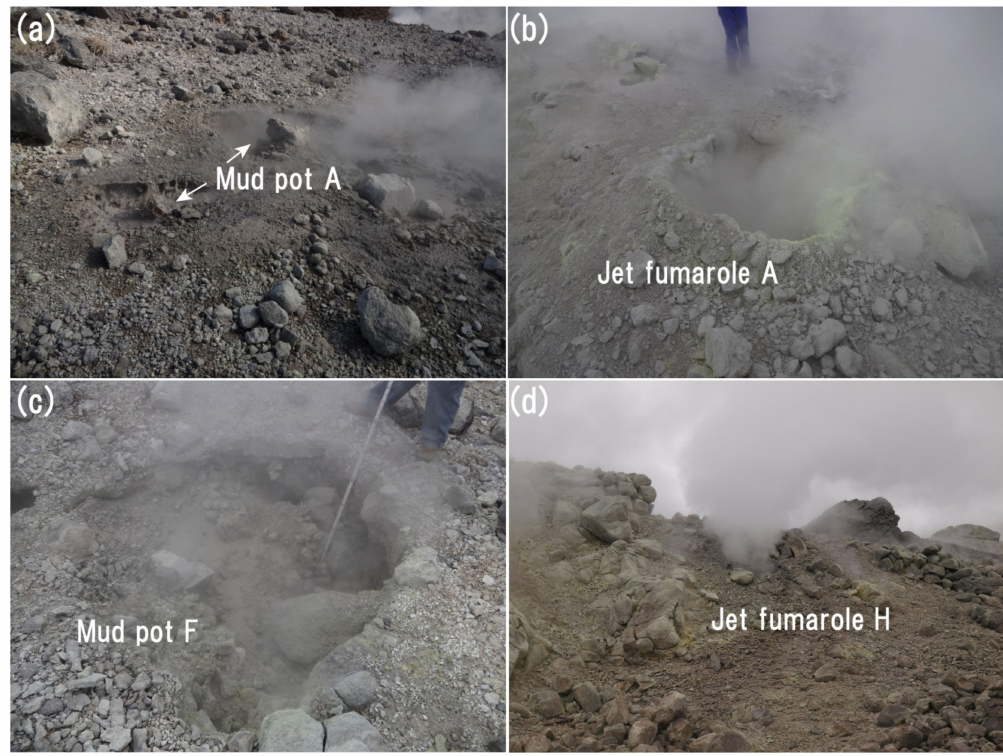
Figure 5. Details of geothermal activity at Ioyama fumarole area during Stage-3. ( a ) Mud pot A appeared just before / on 19 March 2017 (Photo on 19 March); ( b ) Jet fumarole A appeared on 26 April 2017 (Photo on 7 May); ( c ) Mud pot F appeared between 19 and 21 March 2017 (Photo on 22 April); ( d ) Jet fumarole H appeared between 15 and 18 April 2017 (Photo on 22